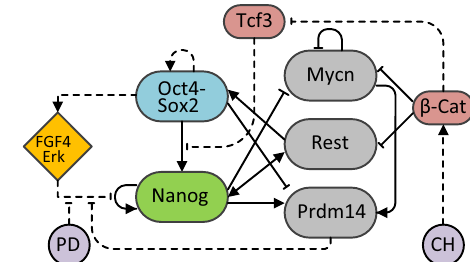
Fig. 1 Scheme of the regulatory network. The core network is composed of the Oct4-Sox2 heterodimer and Nanog; Mycn, Rest and Prdm14 were added as genes differentially expressed in serum/ LIF vs. 2i/LIF, and involved in feedback loops with the core network (detailed derivation in Supplementary Fig. S1). Fgf4/Erk, β -catenin and Tcf3 are added to account for the inputs (i.e., PD and Chiron -CH in the Figure-, the two inhibitors present in 2i/LIF). Solid and dashed lines indicate transcriptional and non-transcriptional interactions,